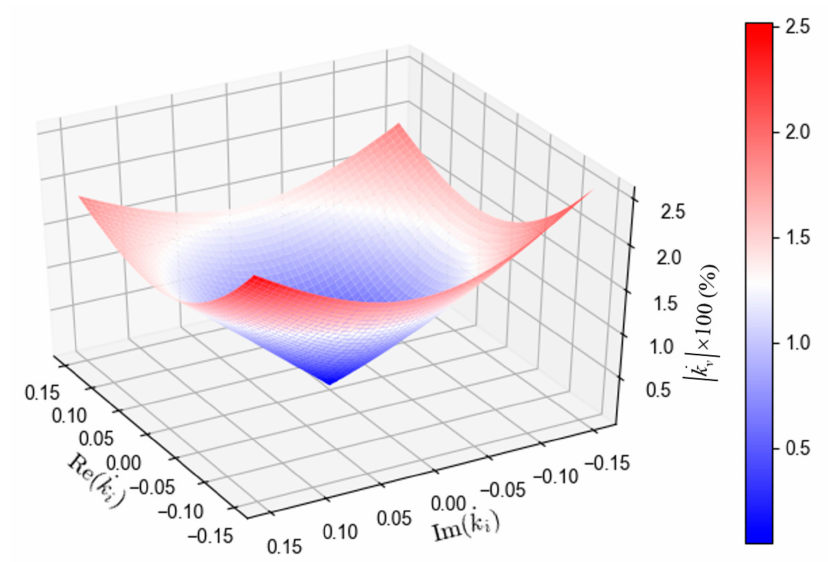
Figure 8. Voltage unbalance rate when line impedance is balanced. From Figure 8, it can be confirmed that when the current unbalance